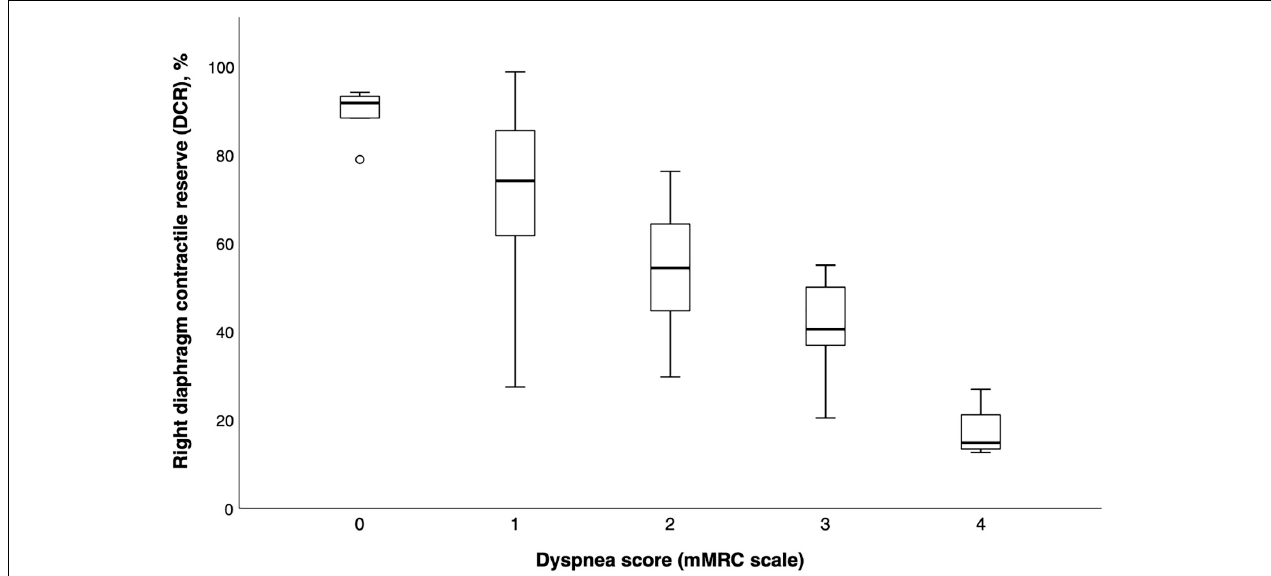
FIGURE 2 | Boxplot graph of diaphragm contractile reserve values according to dyspnea levels (mMRC scale).